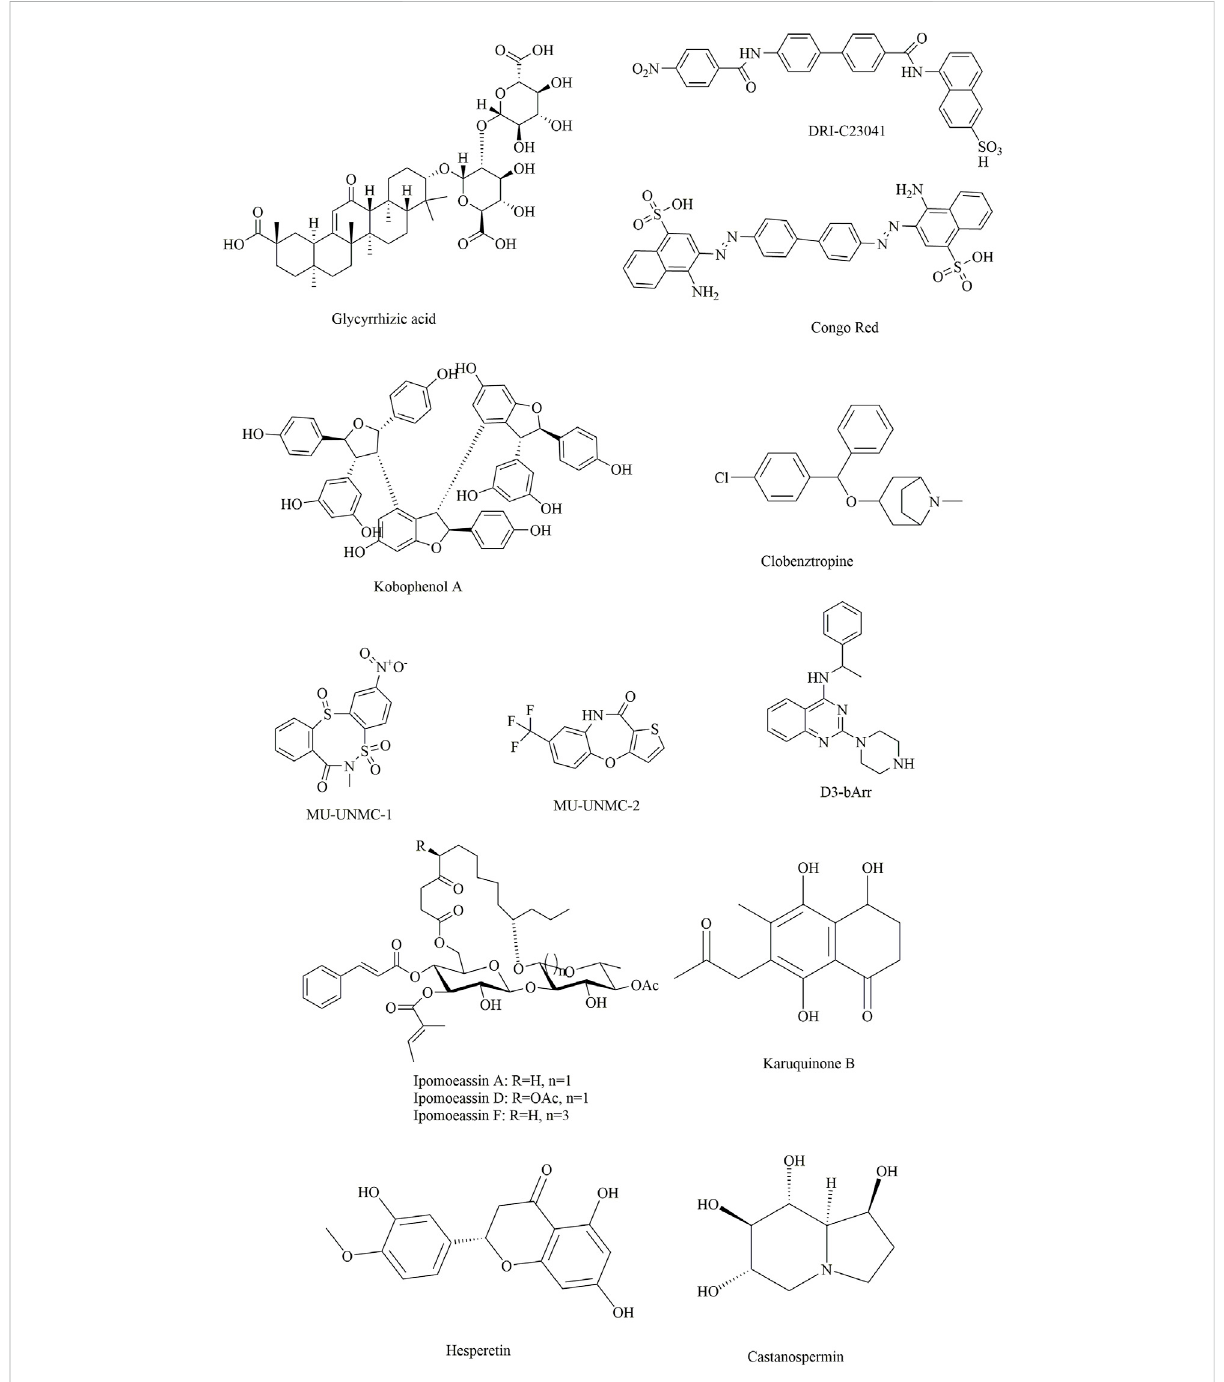
FIGURE 9 Several potential natural products showing inhibitory effects against